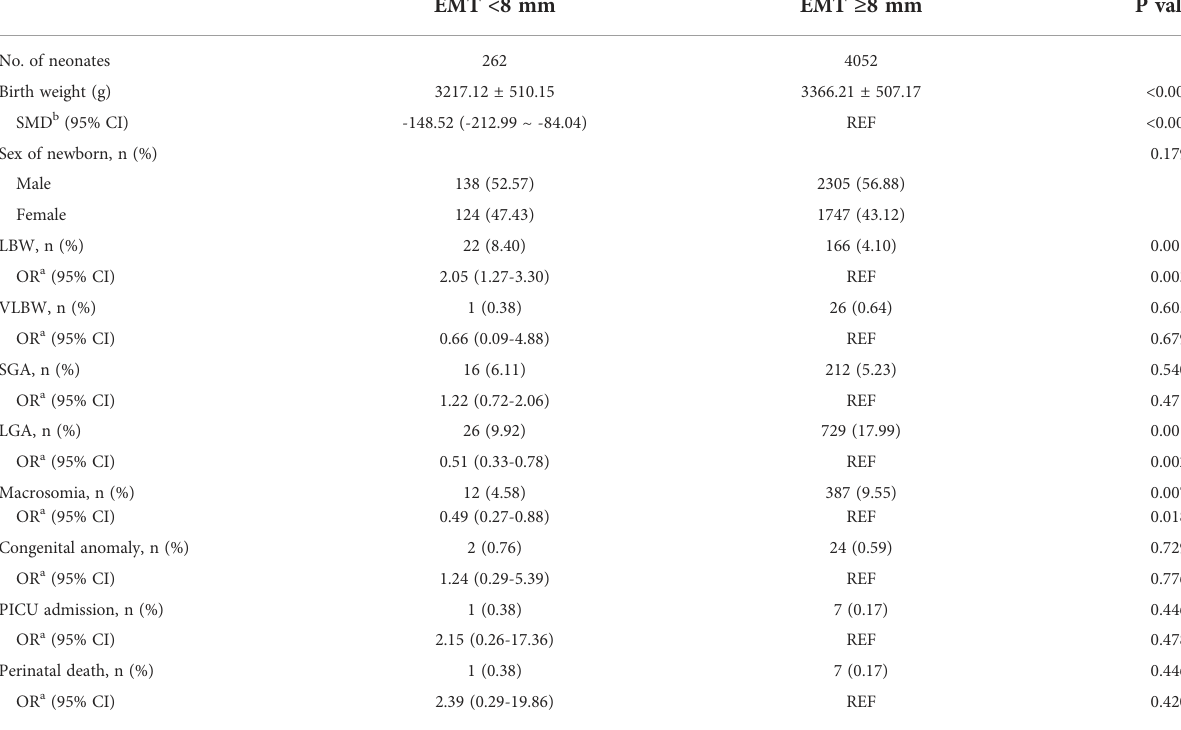
TABLE 3 Neonatal outcomes as a function of